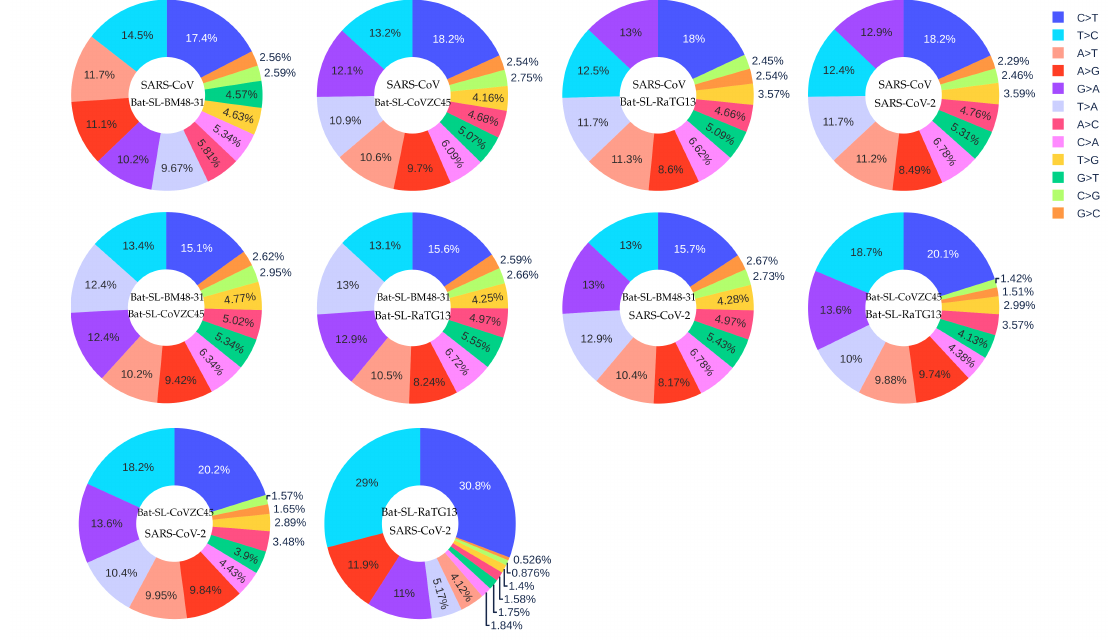
Figure 10. The distribution of 12 SNP types among SARS-CoV, Bat-SL-BM48-31, Bat-SL-CoVZC45, Bat-SL-RaTG13, and SARS-CoV-2. Here, the text at the top represents the reference genome and the text at the bottom represents the mutant